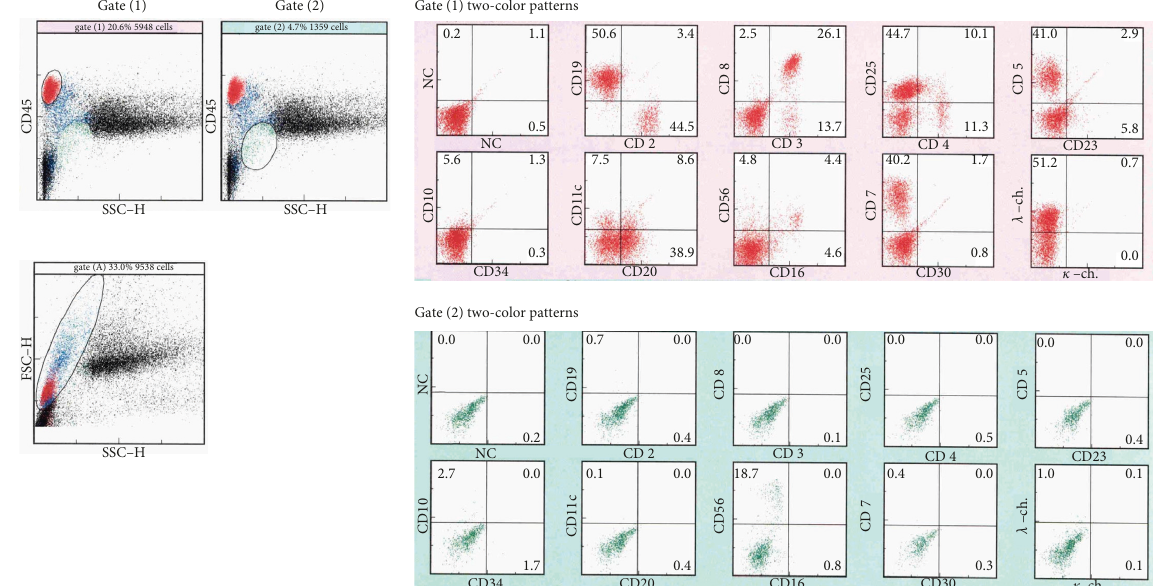
Figure 5: Flow cytometry analysis (CD45/SSC-H gating) of bone marrow before R-THPCOP. Two-color patterns in gate (1), and gate (2).